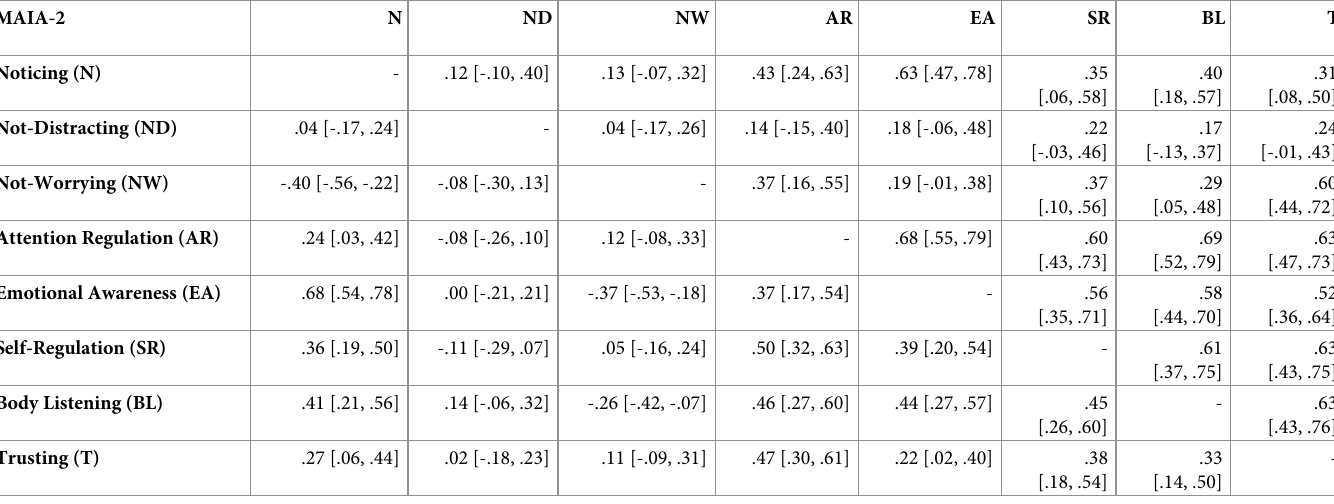
Table 4. Zero-order correlations between MAIA-2 scales (below the diagonal: pre-treatment, n = 110; above the diagonal: post-treatment, n = 87). MAIA-2 N ND NW AR EA BL T Noticing (N)